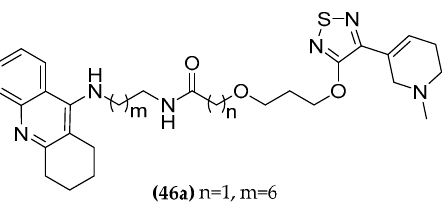
Figure 24. Dual-active AChE inhibitor/mAChR agonist compounds.